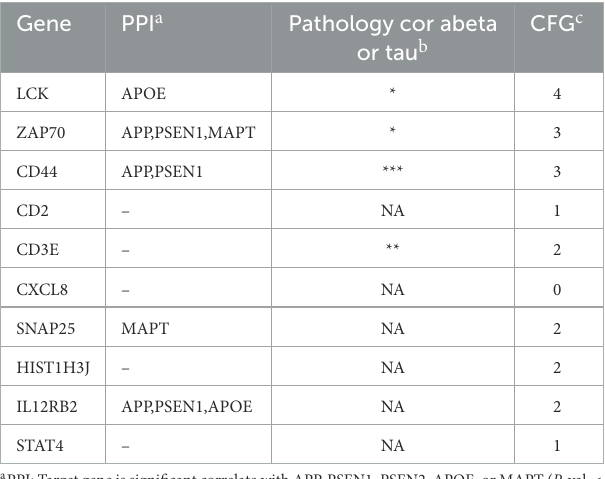
TABLE 2 The convergent functional genomic (CFG) result of hub genes.